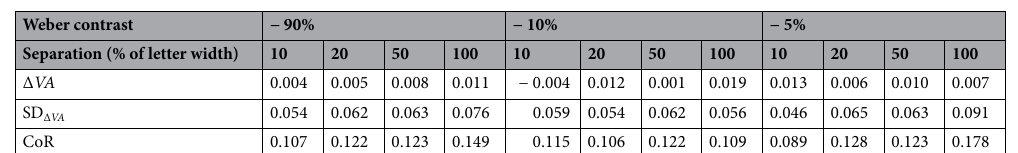
Table 2. Mean differences, Δ VA (logMAR) of the test–retest measurements (see Table 1), the associated standard deviations SD Δ VA , and coefficients of repeatability CoRs (1.96 × SD Δ VA ) under all contrasts and letter separations tested.